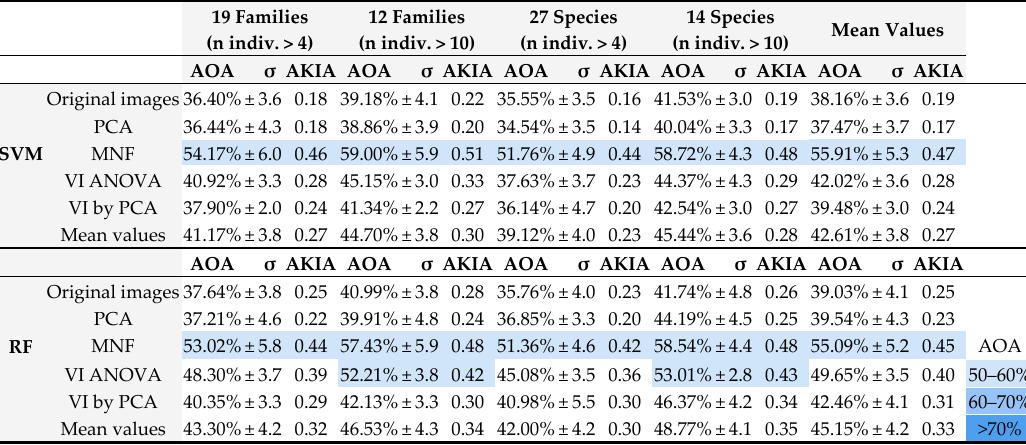
Table 4. Urban tree diversity classification averaged overall accuracies (AOA) and averaged Kappa index of agreement (AKIA) obtained using the 2-folds learning method and applied on each reduced hyperspectral image, and on the original (hyperspectral and Sentinel2) image datasets with RF and SVM according to the four sub-levels for families and species datasets.